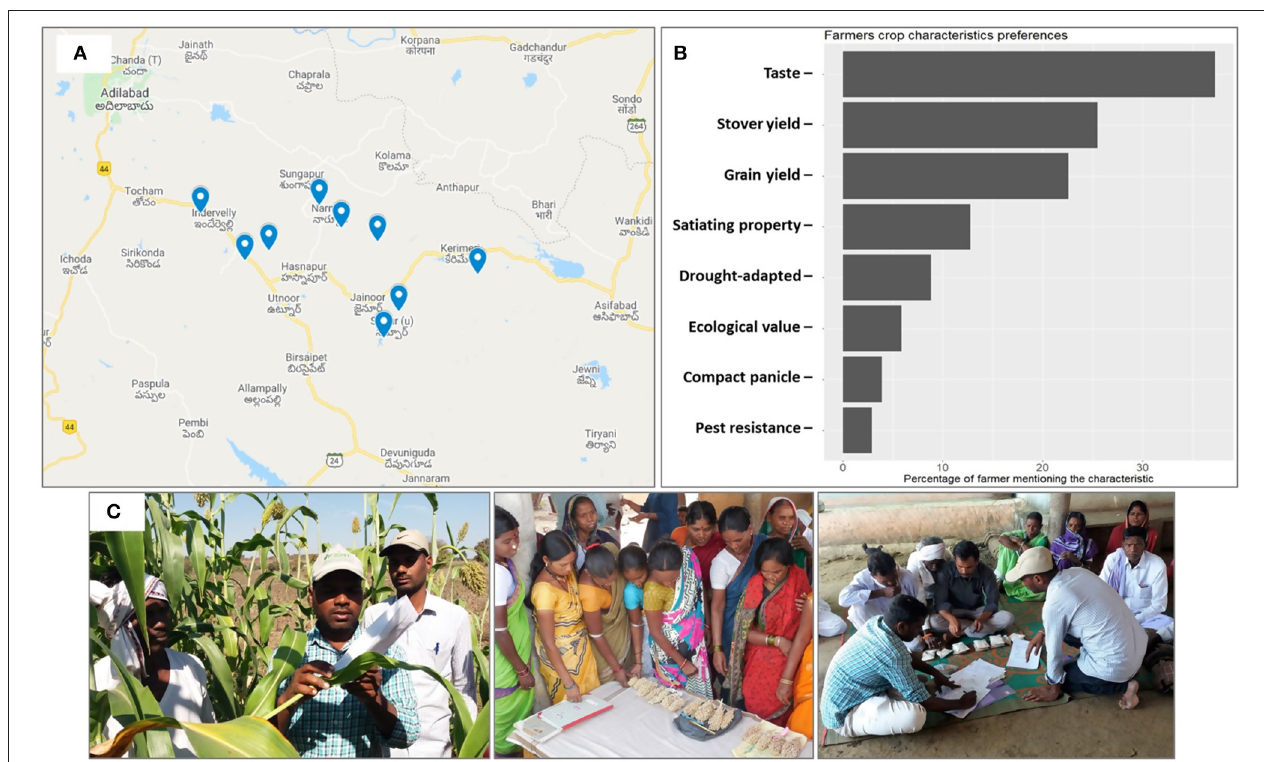
FIGURE 4 | (A) Geo-tagged positions of the villages in Adilabad district where ex ante survey and farmer-participatory varietal selection trials were conducted during 2017–18 and 2018–19; (B) Farmers’ preferences collated from the 103 farmer interviews and focus group discussions conducted in the years 2018–20; (C) Collage of pictures from our participatory work at study